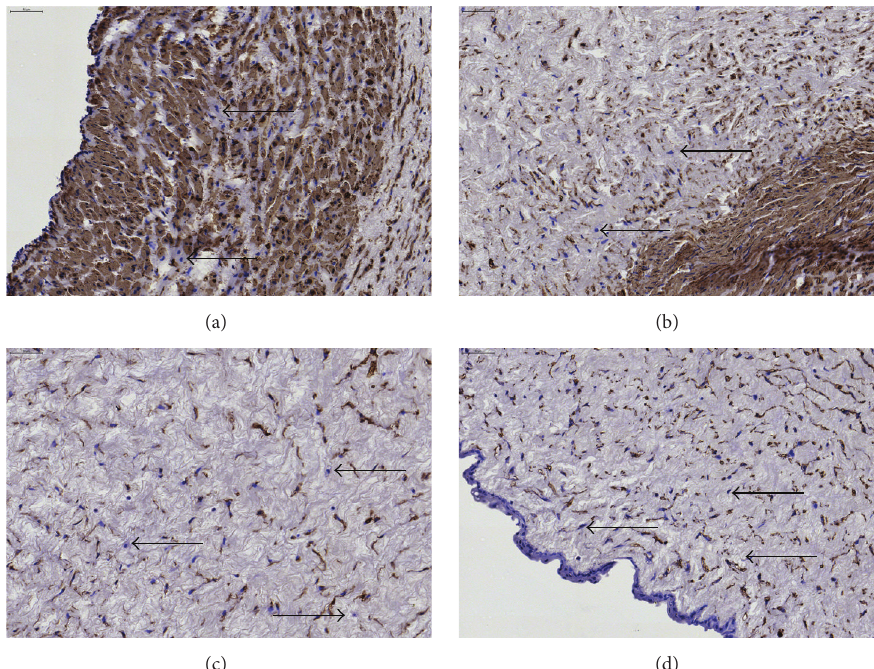
Figure 2: Staining of umbilical cord tissue for 𝛼 SMA expression (brown). Images are shown for umbilical cord areas: (a) vein, (b) arteries, (c) Wharton’s jelly, and (d) cord edge and amniotic epithelium. Slides were counterstained using Mayer’s hematoxylin (dark blue = cell nuclei). Scale bars = 50 𝜇 m. Unstained cells (black arrows) are found in all anatomical compartments of the cord. Representative images of 3 different experimentsareshown.ImagesofcontrolstainingwithoutprimaryantibodyareavailableintheelectronicSupplementaryMaterial,Figure S1, available online at http://dx.doi.org/10.1155/2016/5457132. Scale bars = 50 𝜇 m (top left